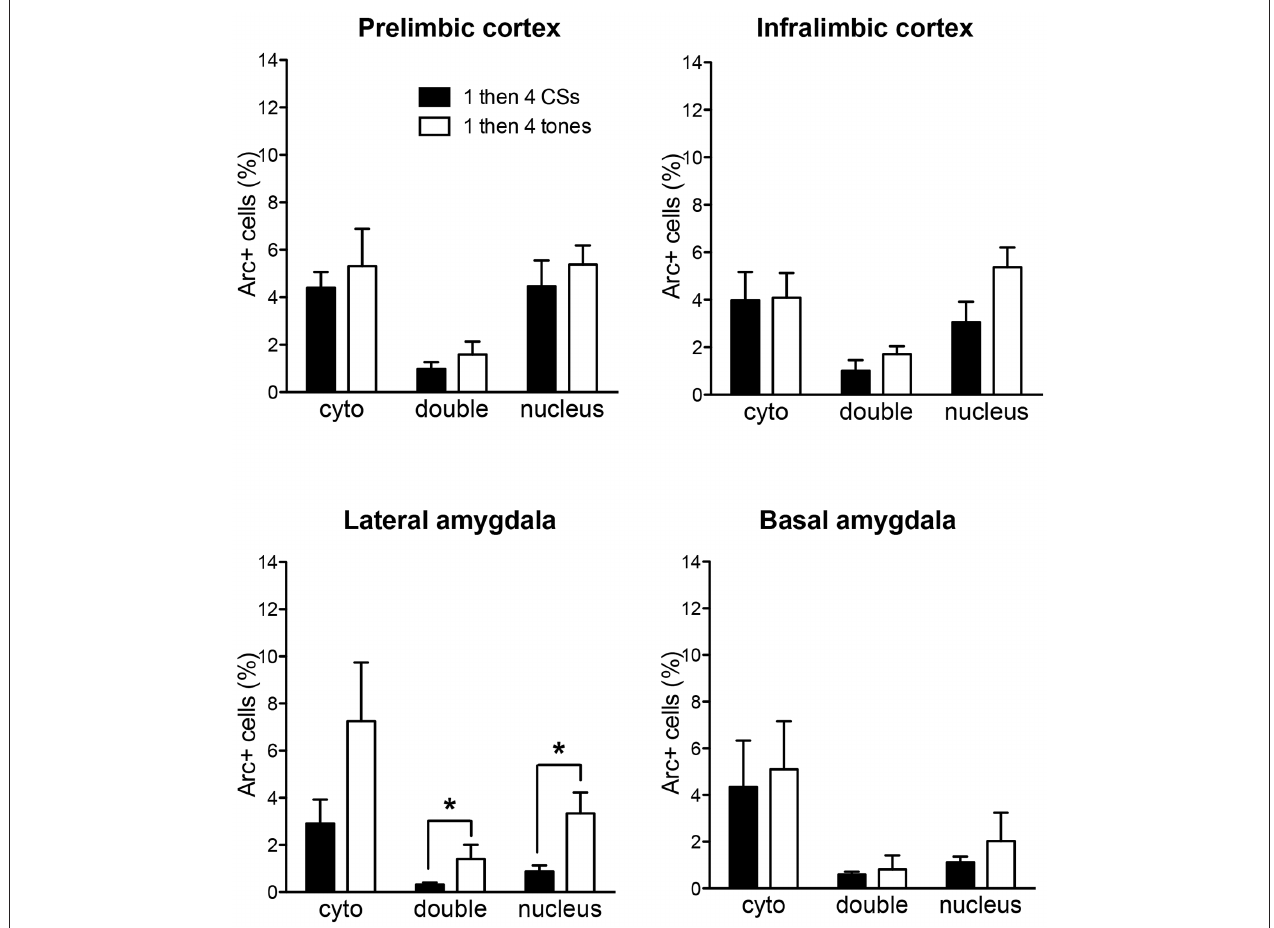
FIGURE 5 | The bar graphs show percentage of DAPI+ cells expressing Arc mRNA in the cytoplasm (cyto), nucleus, or both (double) of the 1 then 4 CSs group ( n = 6) shown in Figures 2, 3 and the non-fear conditioned control group (1 then 4 tones, n = 3) that received identical CS presentations. * p <